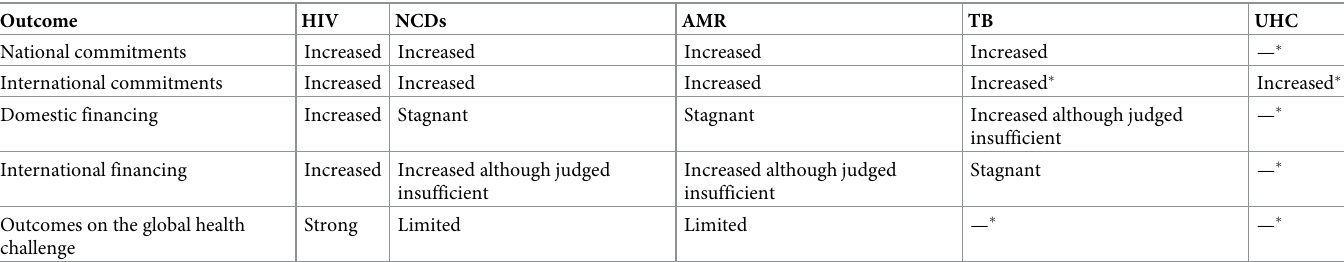
Table 3. Overview of high-level event outcomes.